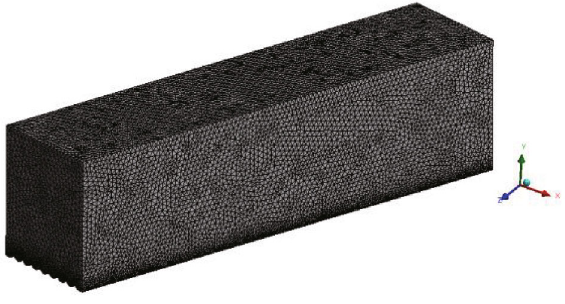
Figure 9: Mesh of computational domain. Table 2: Flow quantity of outlet with di ff erent in fl ow speeds.